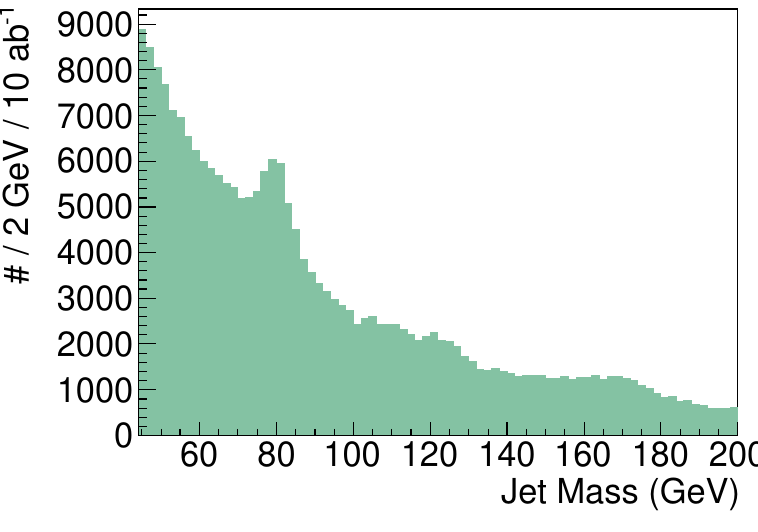
Figure 6 . The jet-mass distribution for the Sample Point